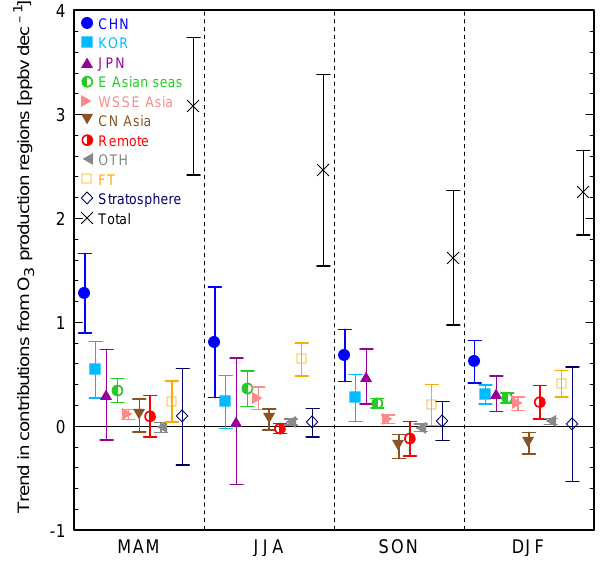
Figure 8. Linear trends in the contributions in 1980–2005 from source regions to surface O 3 over Japan in different seasons: spring (MAM), summer (JJA), fall (SON), and winter (DJF). Error bars are 95% confidence